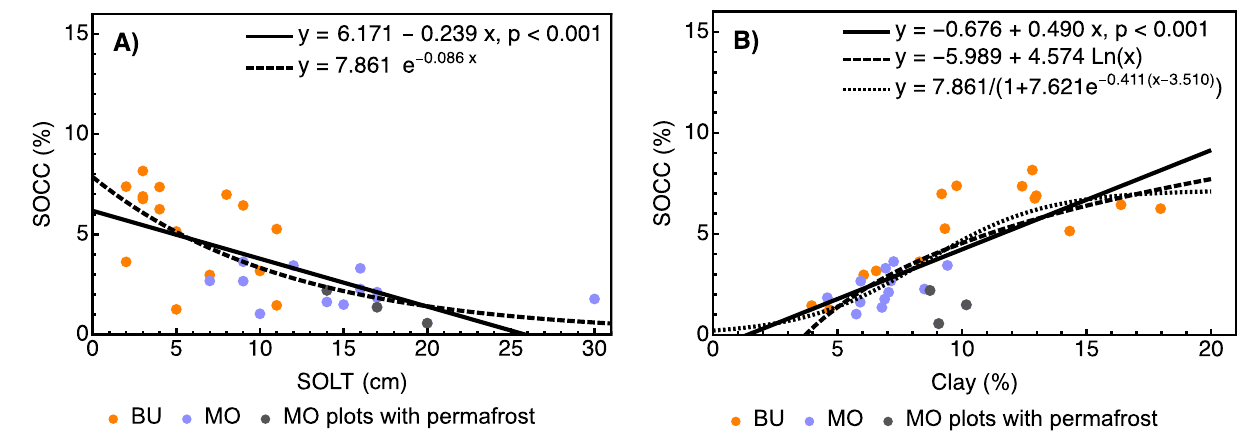
Figure 3. ( A ) Relationship between soil organic carbon concentration (SOCC) and surface organic layer thickness (SOLT). Linear fit: adj. R 2 = 0.421; RMSE = 1.762; AIC = 123.144. Exponential fit: RMSE = 1.631; AIC = 118.496. ( B ) Relationship between SOCC and the clay content. Linear fit: adj. R 2 = 0.533; RMSE = 1.581; AIC = 116.636. Logarithmic fit: RMSE = 1.568; AIC = 116.135. Sigmoid fit: RMSE = 1.544; AIC = 117.208. BU Bucharama, MO Malyj Orokan, RMSE root mean squared error, AIC Akaike information criterion.